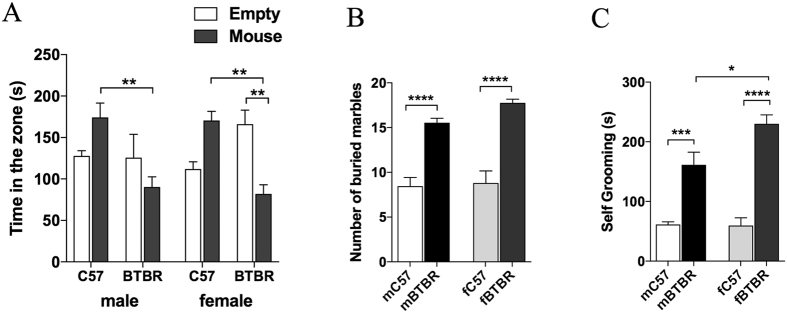
Analysis of social interaction, stereotyped and repetitive behavior in female and male BTBR mice.(A) Three-chamber social interaction test showing time spent in each chamber by BTBR and C57 mice of both sexes (n = 12/group; p = 0.7424 for chamber, p = 0.0077 for strain, p = 0.7761 for sex, p < 0.0001 for chamber x strain and p = 0.1671 for chamber x strain x sex, by three-way ANOVA). (B) Number of buried marble by BTBR and C57 mice of both sexes after a 30 min testing session (n = 12/group; p < 0.0001 for strain, p = 0.1322 for sex and p = 0.2689 for strain x sex, by two-way ANOVA). (C) Seconds spent in repetitive grooming measured for BTBR and C57 mice of both sexes during 10 min test session (n = 12/group; p < 0.0001 for strain, p = 0.0372 for sex, and p = 0.0269 for strain x sex, by two-way ANOVA). Significant differences are indicated by *p < 0.05, **p < 0.01, ***p < 0.001 and ****p < 0.0001 using Bonferroni post-hoc tests following three-way ANOVA with chamber, strain and sex as factors (A) or two-way ANOVA with strain and sex as factors (B and C). Abbreviations: fBTBR (BTBR female mice); mBTBR (BTBR male mice); fC57 (C57 female mice); mC57 (C57 male mice). Data are shown as mean values ± SEM.